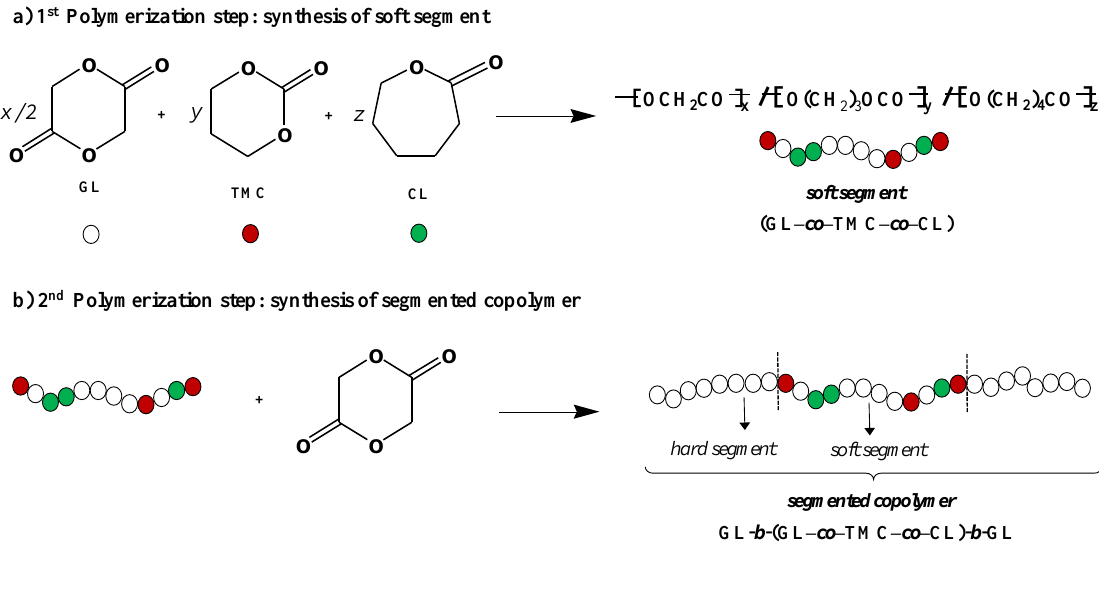
Figure 1. Two step synthesis of GL- b -[GL- co -TMC- co -CL]- b -GL showing the chemical structure of soft and hard